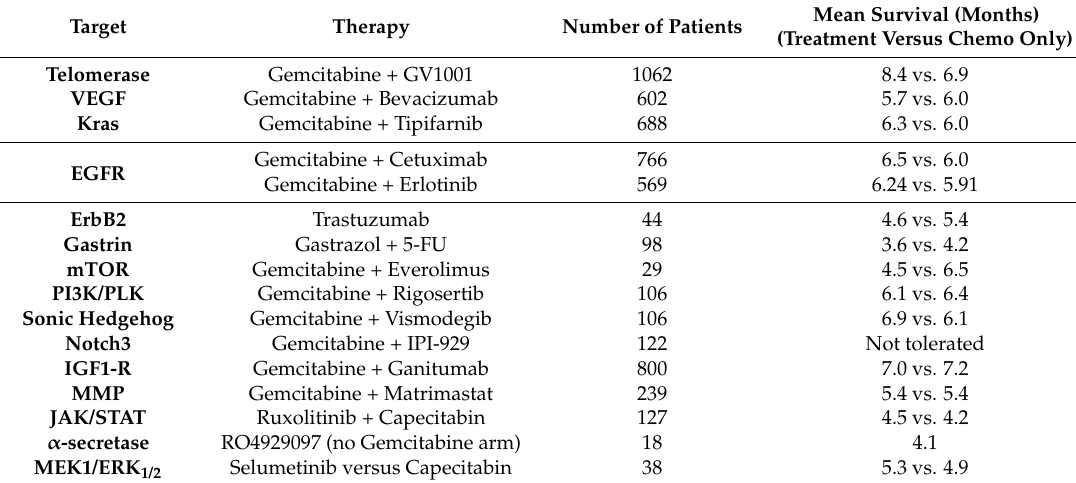
Table 4. Outcome of initial clinical trials for targeted therapies in pancreatic cancer . Some of the targeted therapies listed here did not have a high selectivity towards their targets